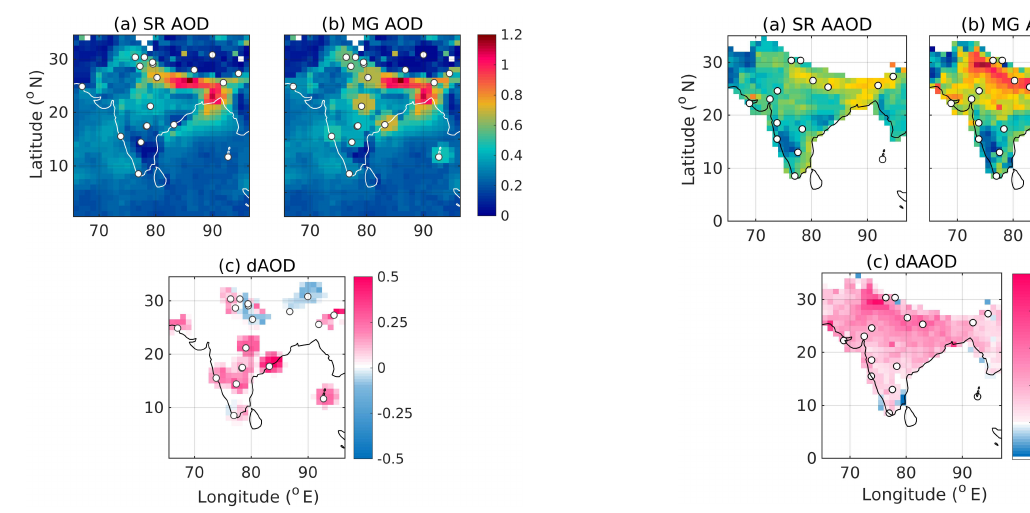
Figure 6. Spatial variation of monthly mean SR AOD (a) , MG AOD (b) and dAOD (c) for January 2009.